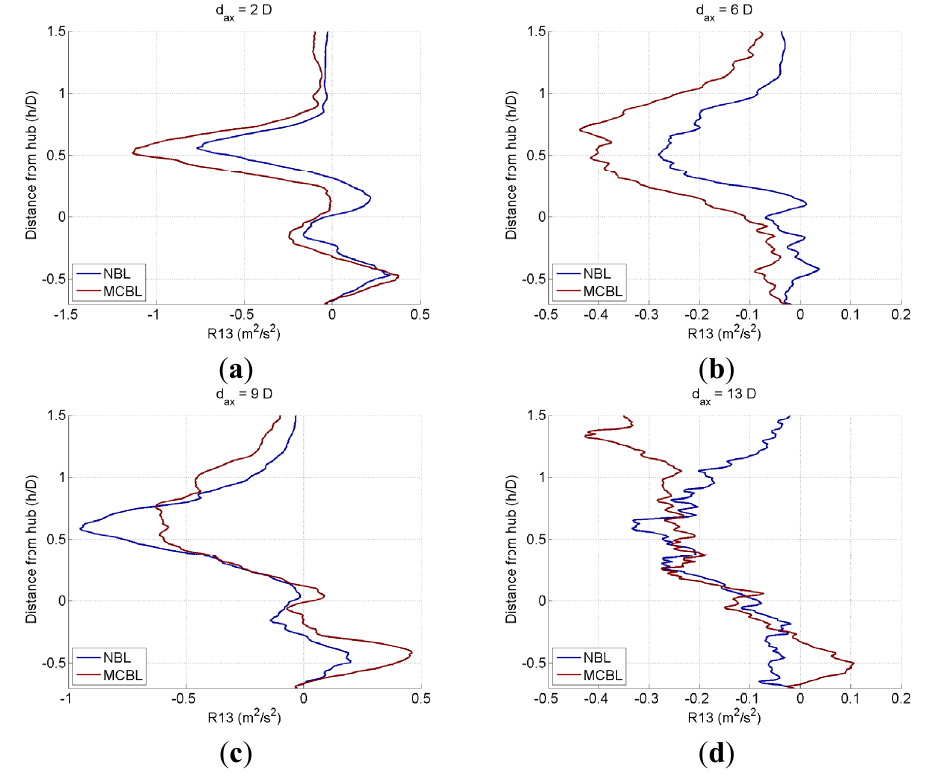
Figure 11. Reynolds stress R 13 distribution in the vertical direction. (Turbine-Turbine Interaction Problem, V Wind = 8 m/s). ( a ) 2D downstream of Turbine 1; ( b ) 6D downstream of Turbine 1; ( c ) 2D downstream of Turbine 2; ( d ) 6D downstream of Turbine